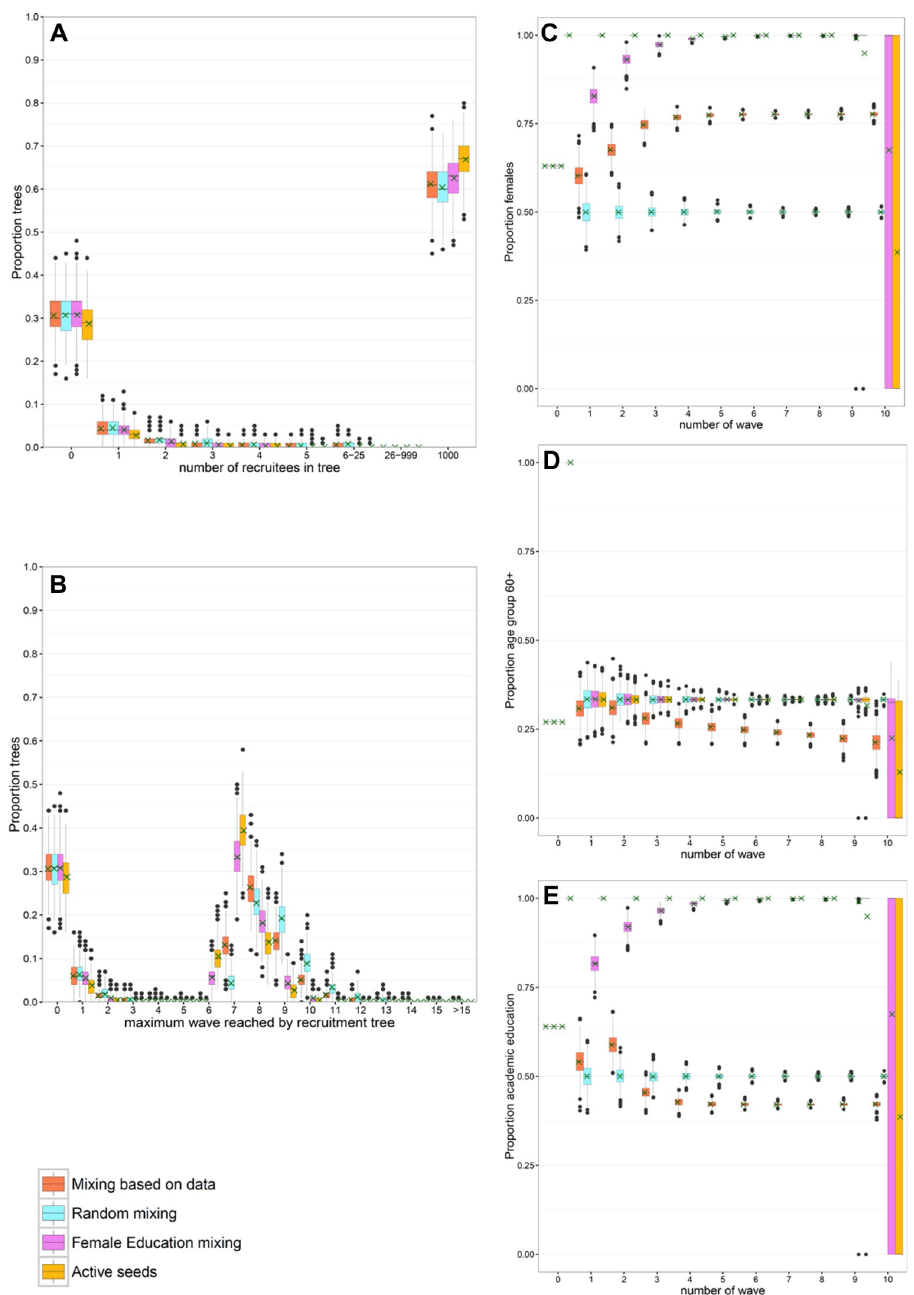
Fig 4. Scenario analyses of mixing behaviour. We ran simulations starting with 100 seeds with characteristics randomly drawn from the observed data (scenarios S15 to S17) and 100 active seeds (scenario S18), 1000 runs per seed. The boxplots show the variability between runs. The legend refers to scenarios S15 to S18 described in Table 3. ( A ) Number of recruitees in recruitment trees in one simulated data set; ( B ) wave reached by recruitment trees in one simulated data set. Plots C to E show, for each wave of large recruitment trees, the variability in composition of each simulated data set, with ( C ) proportion of females, ( D ) age group 60+ and ( E ) having an academic education. A green cross indicates, for each wave, the mean proportion over all simulated data